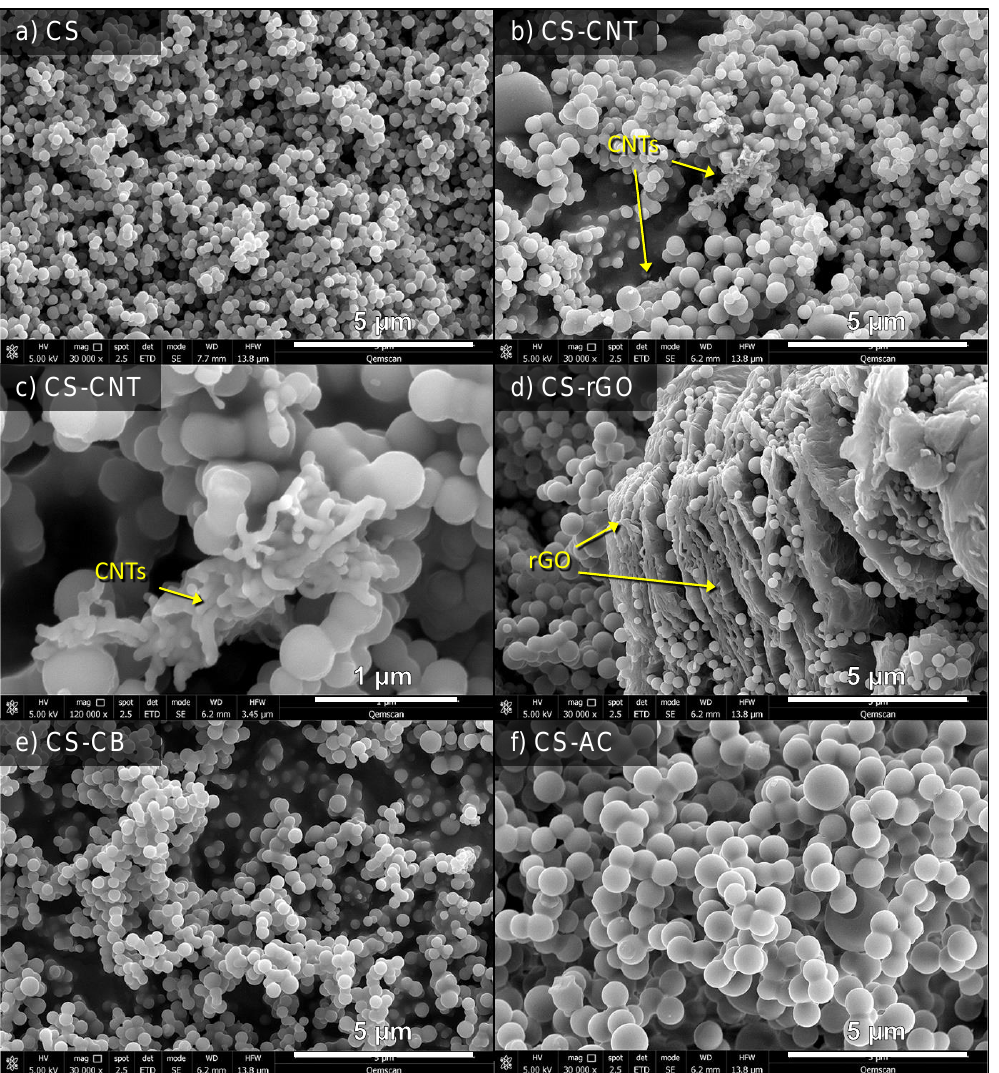
Figure 1. Morphology of the pure glucose and glucose–carbon hybrids: ( a ) CS, ( b , c ) CS-CNT, ( d ) CS-rGO, ( e ) CS-CB and ( f ) CS-AC. Table 1. Textural parameters and pH PZC for the different carbon supports.